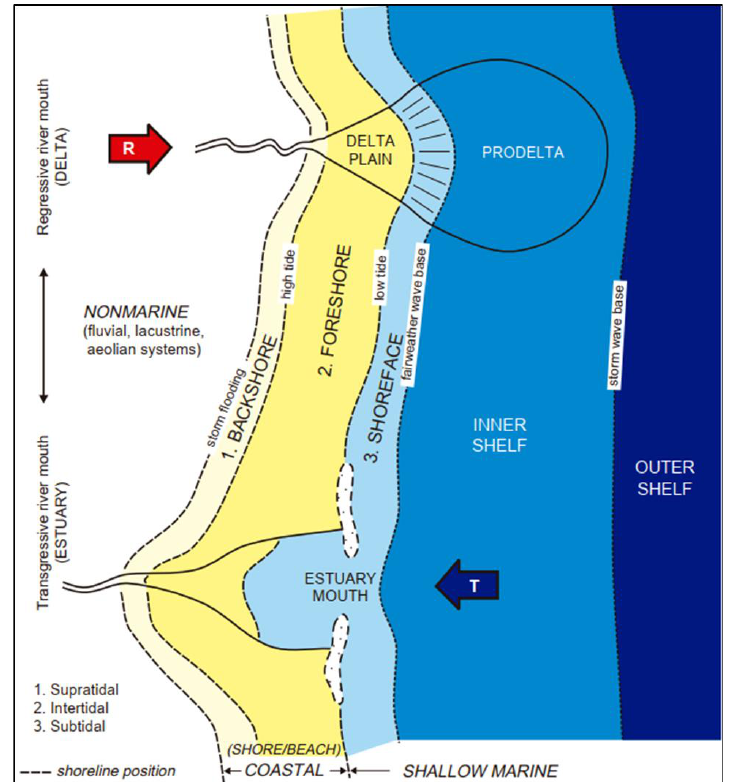
Figure 5. A diagram showing the depositional environments during periods of base level ascending and descending. Overall, H field is in a coastal shoreface environment but it presents different features depending on base level variations. Deltaic features developed in the period of base level descending (the red arrow), while tidal-influenced shore facies and storm deposition developed in the period of base level ascending (the blue arrow). Cited from [31].